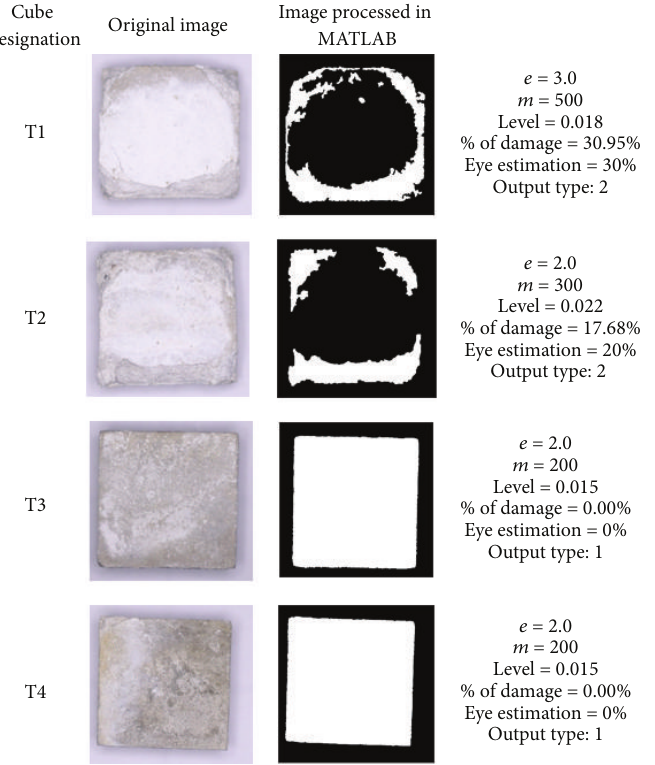
Figure 10: Surface area damage after submergence for 180